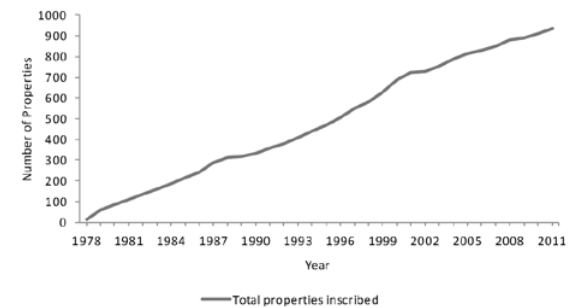
Figure 1: Cumulative of total properties inscribed on the World Heritage List. Data source: UNESCO World Heritage Centre (WHC),